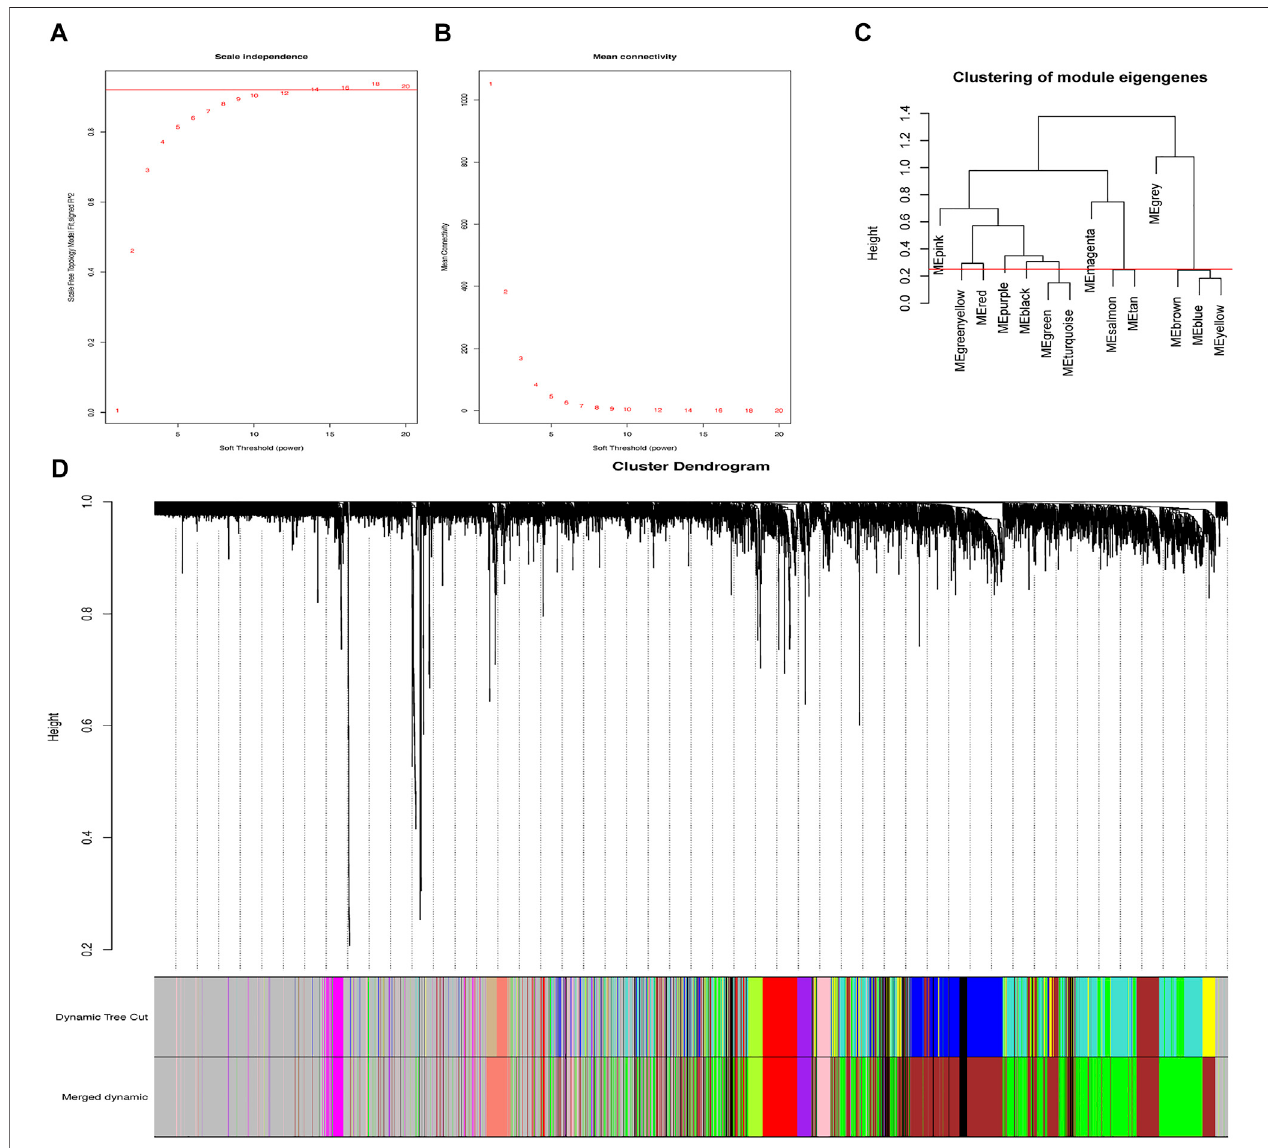
FIGURE 1 | Gene co-expression network. (A) Scale-free fi t parameters of different soft-thresholding powers. (B) According average connectivity of different soft- thresholdingpowers. (C) ClusterofmoduleeigengenesobtainedviaWGCNA. (D) Clusterdendrogram.Thedifferentcolorstandsforthedifferentco-expressionmodule we obtained, while black branches mean the genes contained